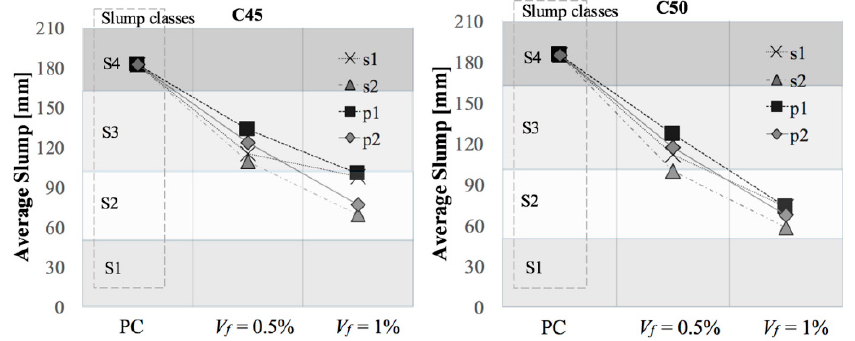
Figure 3. Influence of fibers on slump reduction in concrete C45 ( left ) and C50 ( right ) in case of plain concrete (PC) and fiber reinforced concretes ( V f = 0.5% and V f = 1%).